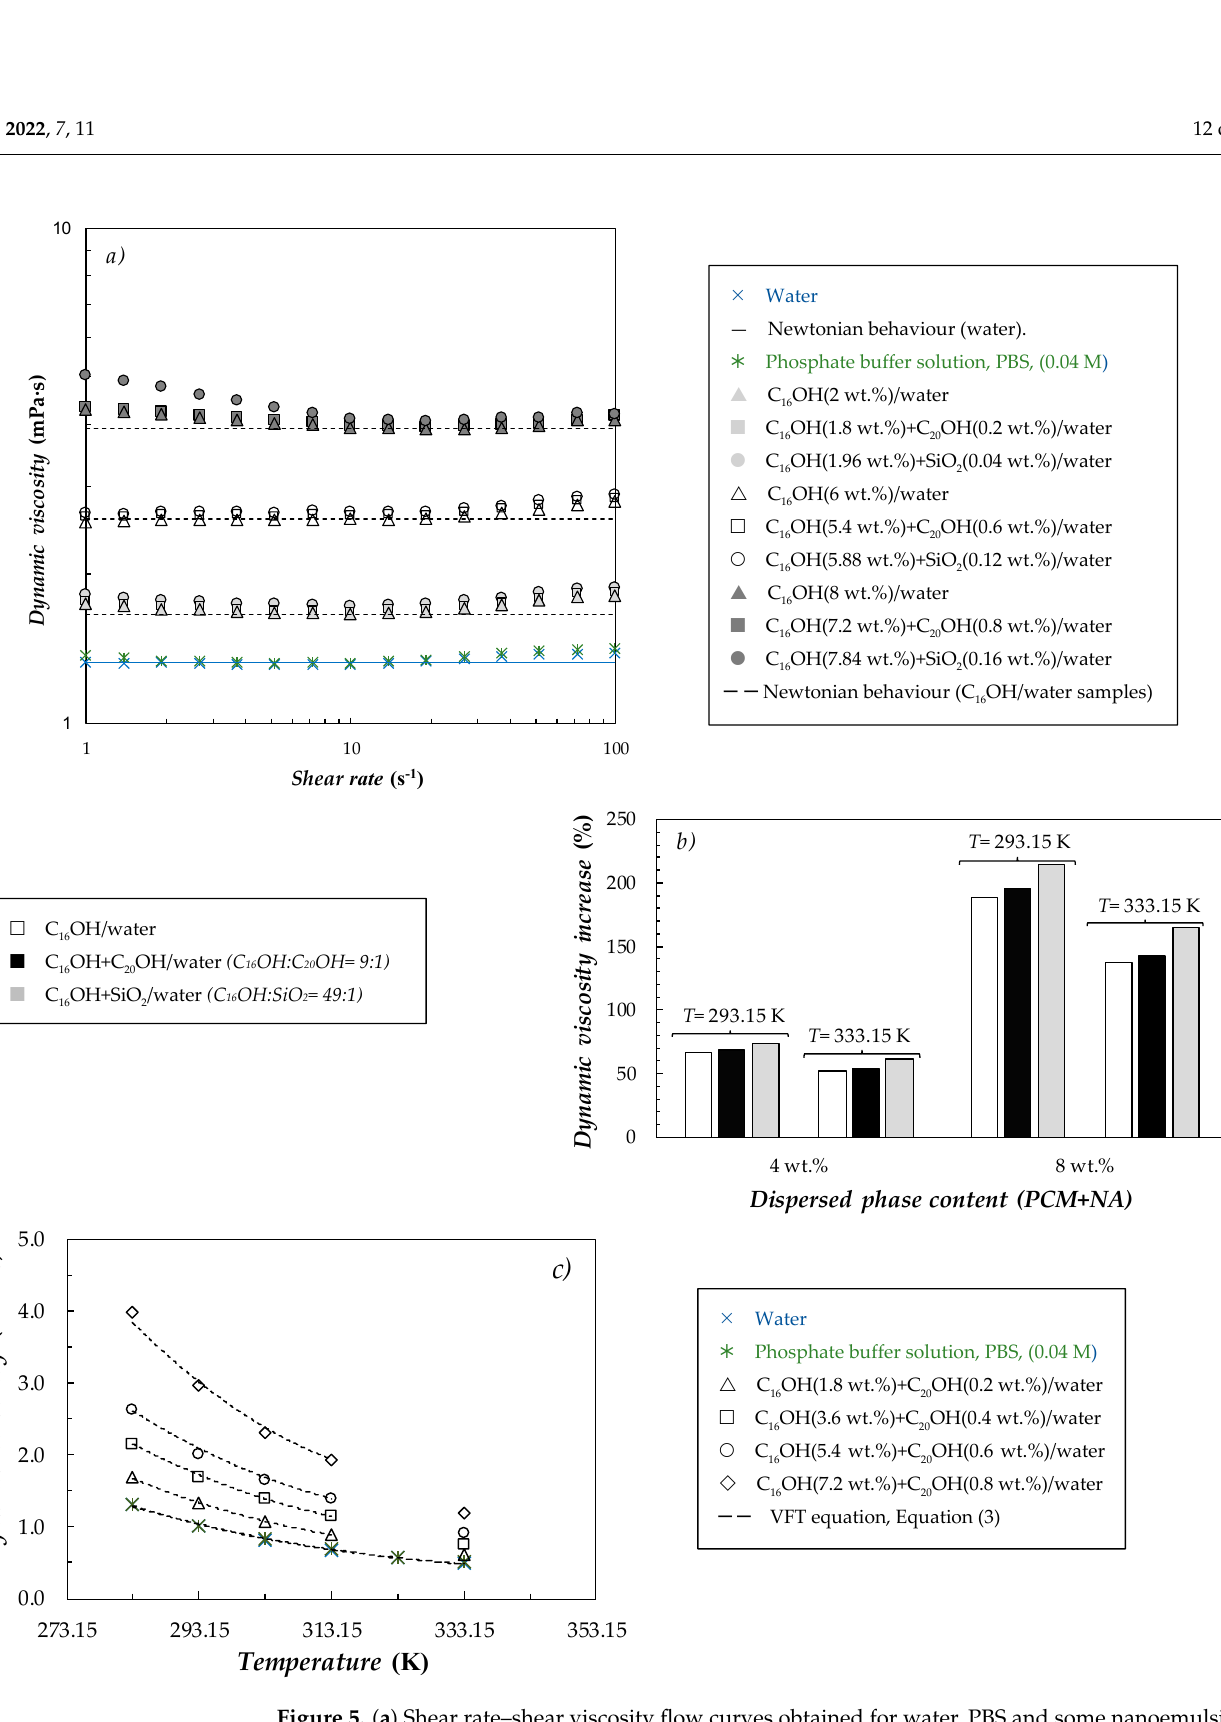
Figure 5. ( a ) Shear rate–shear viscosity flow curves obtained for water, PBS and some nanoemulsions at 283.15 K; ( b ) increases in the viscosity (regarding water) obtained at 293.15 K (solid dispersed droplets) and 333.15 K (liquid dispersed droplets) for emulsions loaded with 4 and 8 wt.% of the dispersed phase and ( c ) temperature dependence of the viscosity for the C 16 OH + C 20 OH/W system. Temperature uncertainty U ( T ): 0.1 K. Viscosity uncertainty U ( µ ): 5%. Table 3. Fitting parameters ( η 0 , D and T 0 ); standard deviations ( s ) and absolute average deviations ( AAD% ) obtained from the Vogel-Fulcher-Tamman-Hesse model, Equation (3), when modeling the temperature dependence of the shear viscosities obtained for some representative samples at ~100 s − 1 .